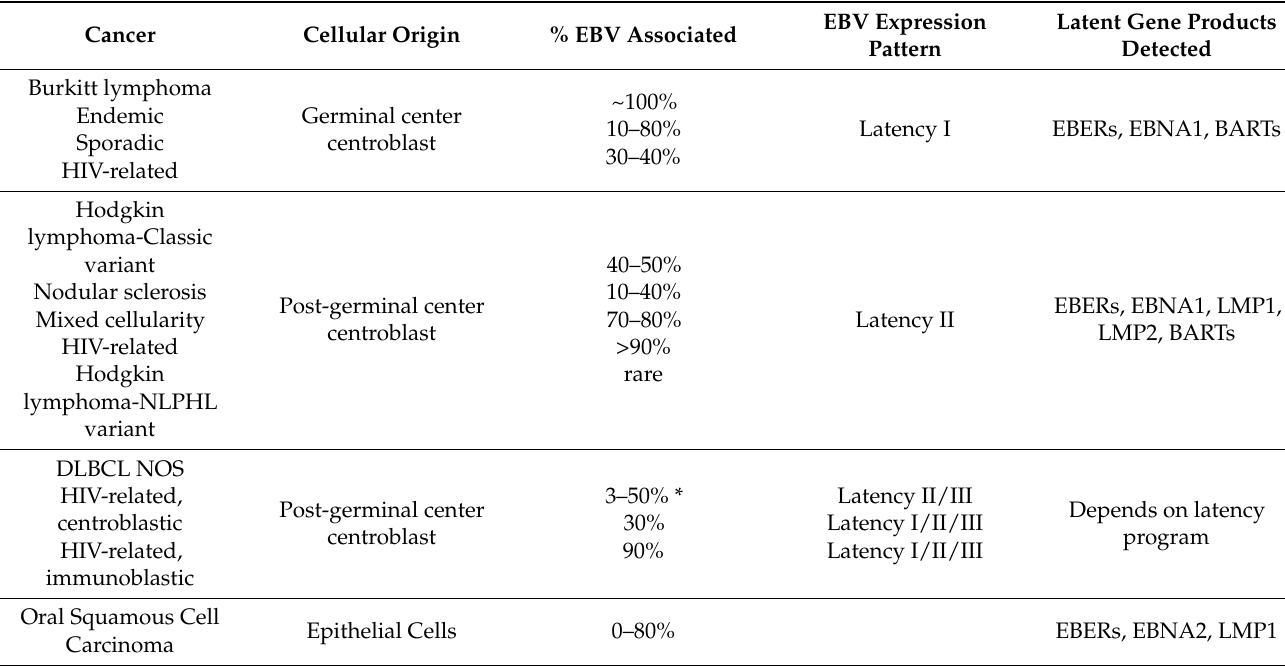
Table 1. EBV prevalence and viral latency program in associated oral cancers and